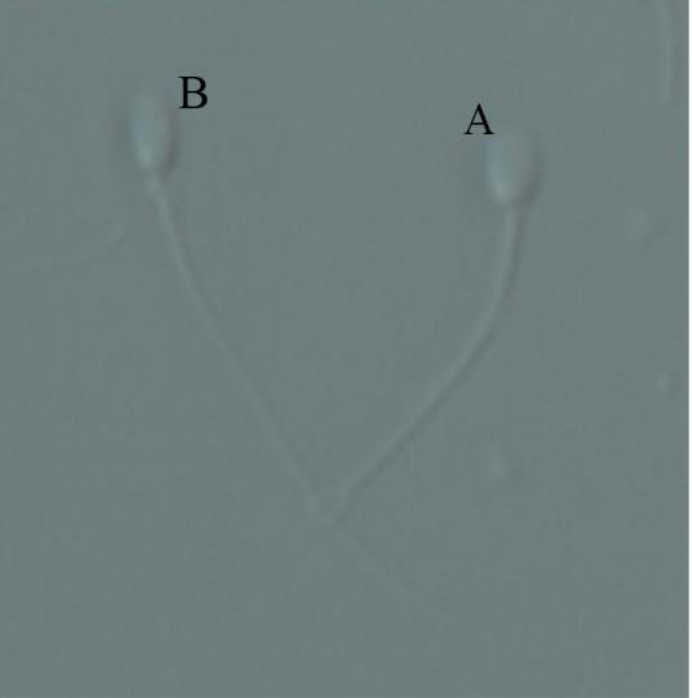
Figure 1. Assessment of sperm plasma membrane integrity using hypo-osmotic swelling test (HOST). Sperm with the coiled tail (A) considered membrane intact; those with the straight tail (B) considered membrane damaged (×200 Magnification).